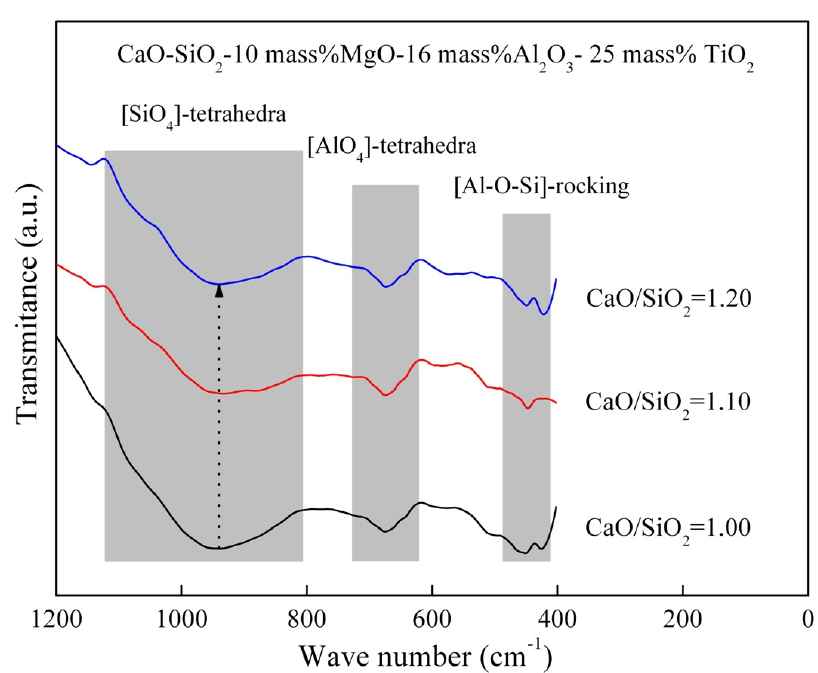
Figure 11. FT–IR transmittance spectra of the slag containing different basicity at 1773 K. Figure 11. FT − IR transmittance spectra of the slag containing different basicity at 1773 K.